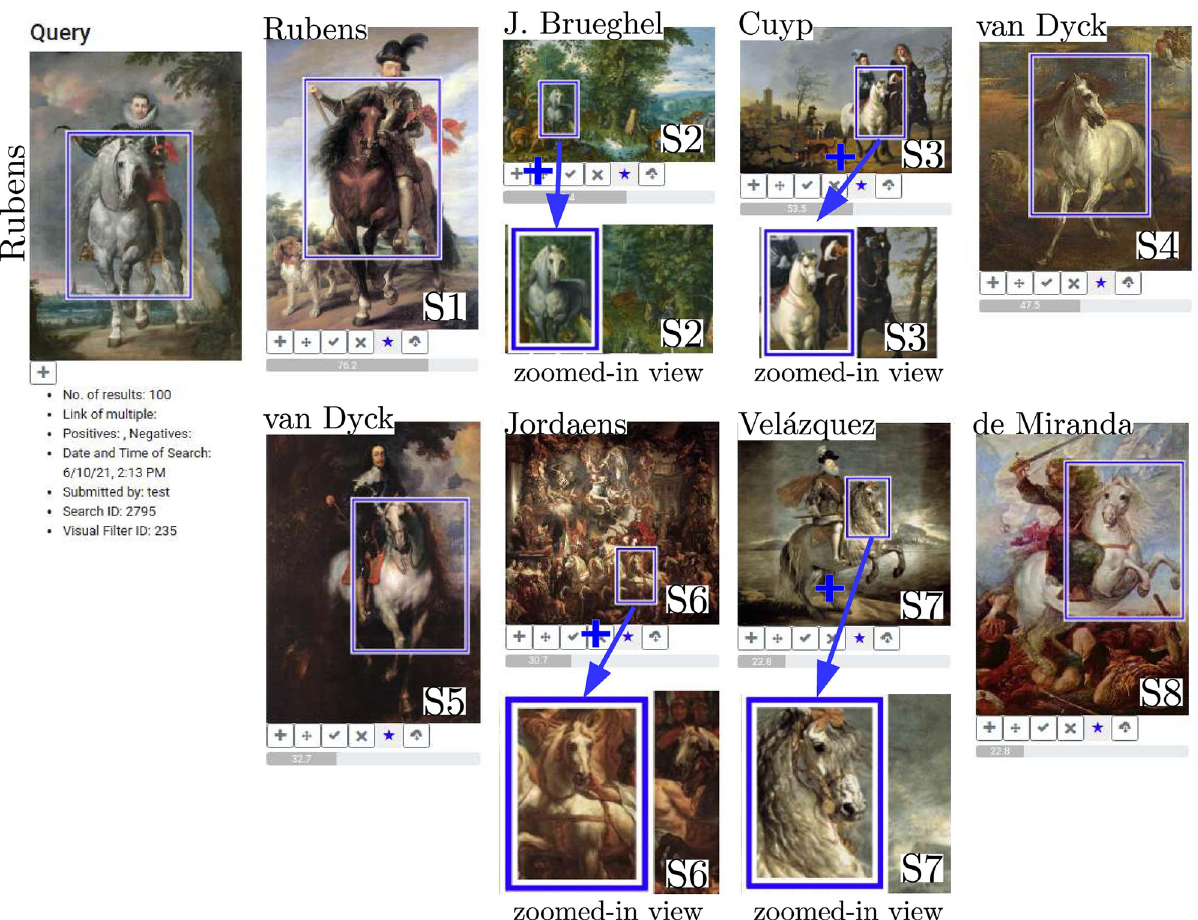
Fig 7. Search results for Rubens’ horse motif. Detail view of our interface showing the search for the motif of the horse in frontal view, a depiction popularized by Peter Paul Rubens. The selected query region is displayed on the left and retrievals marked as particularly interesting are displayed on the right. Favorites were selected from the first 40 results (first two retrieval pages). Additionally, we show the zoomed-in view given by our interface for some images and added the artist’s name. Image material is shared by Wikimedia Commons [5] either as public domain or under a CC0 license.